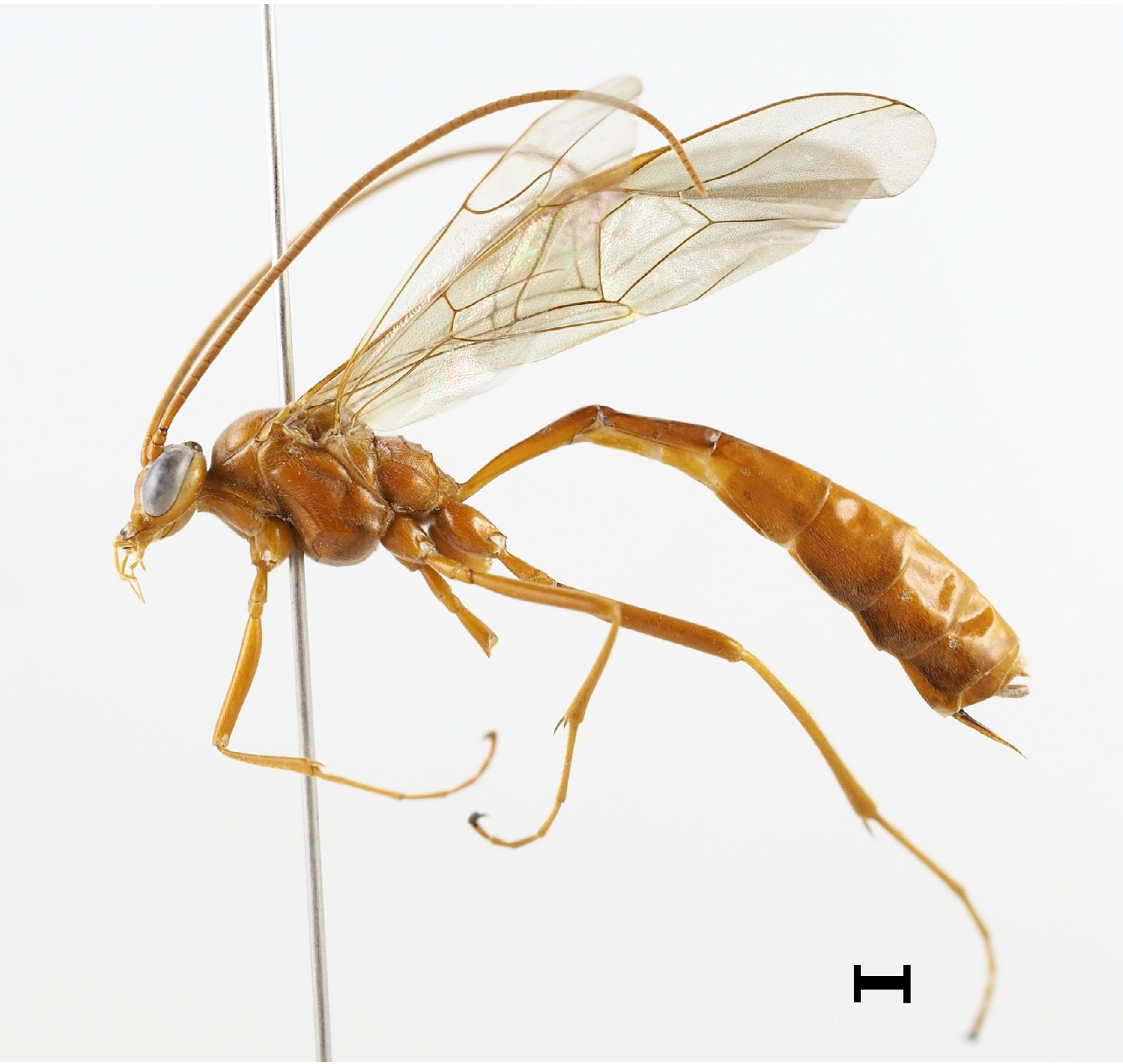
Fig. 36. Ophion matti Johansson sp. nov . , paratype, ♀ (NHRS-HEVA000008679). Scale bar = 1